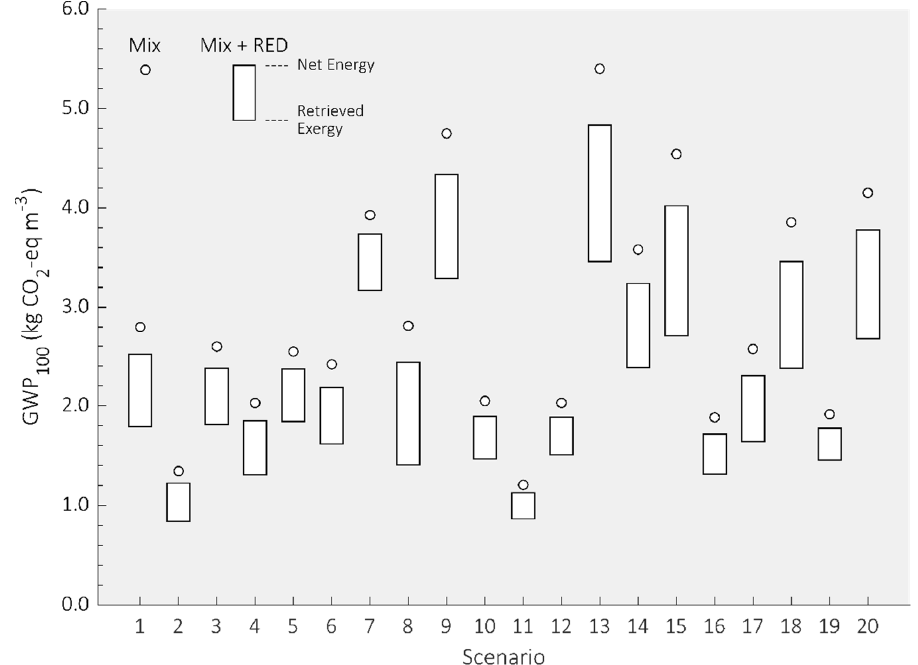
Figure 6. Electricity related GWP per m 3 of permeate according to locations (scenarios 1 to 20) for each energy supply scenario. SEC of SWRO plant met by (i) Grid Mix (BaU); (ii) Grid Mix + RED’s Net Energy (upper limit, “current” scenario); (iii) Grid Mix + RED’s Retrieved Exergy (lower limit, “optimistic” scenario).